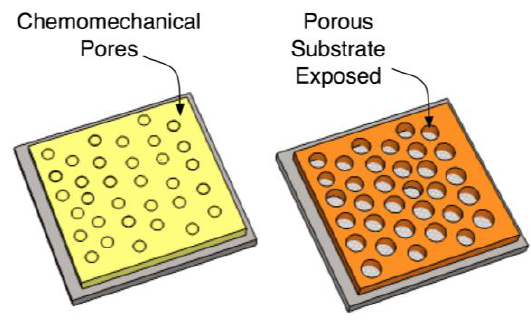
Figure 6. Concept variant inspired by guard cells.